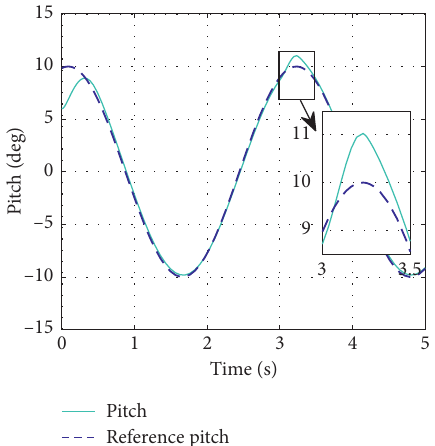
Figure 3: The tracking control result of pitch angle of the aerial tree-pruning